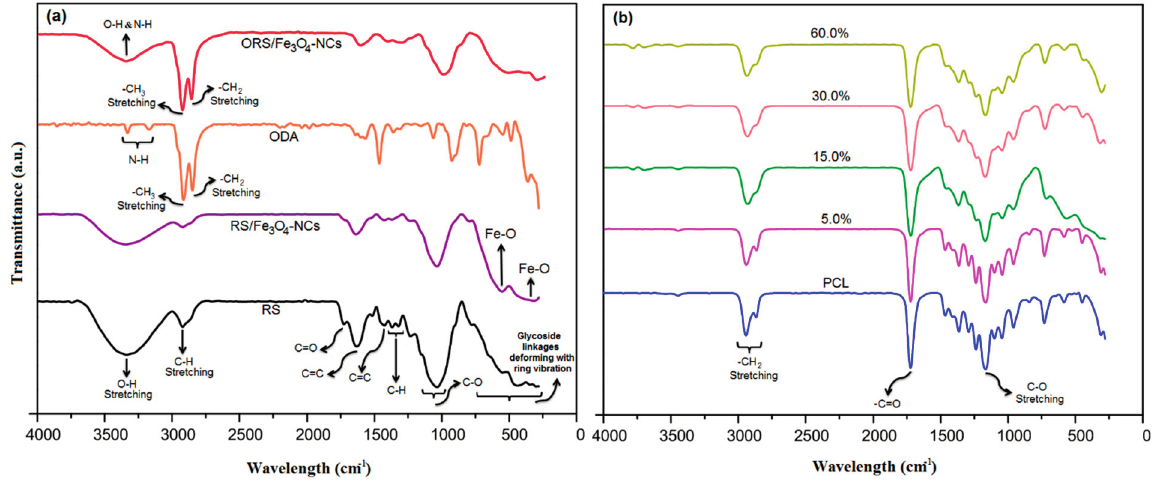
Figure 6. FT-IR spectra of RS, RS/Fe 3 O 4 -NCs, ODA and ORS/Fe 3 O 4 -NCs ( a ), PCL,